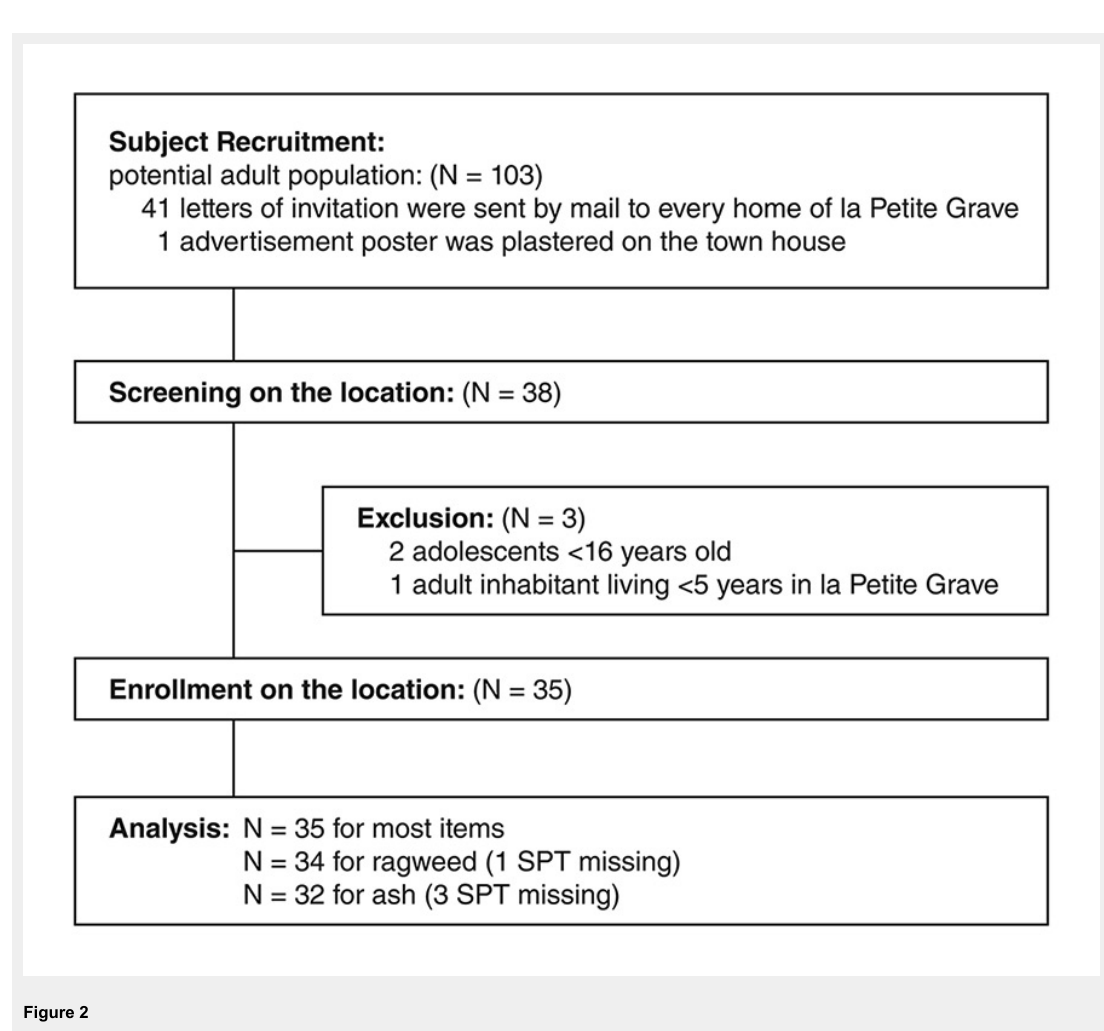
Figure 2 Flow-chart of the recruitment process. SPT = skin-prick